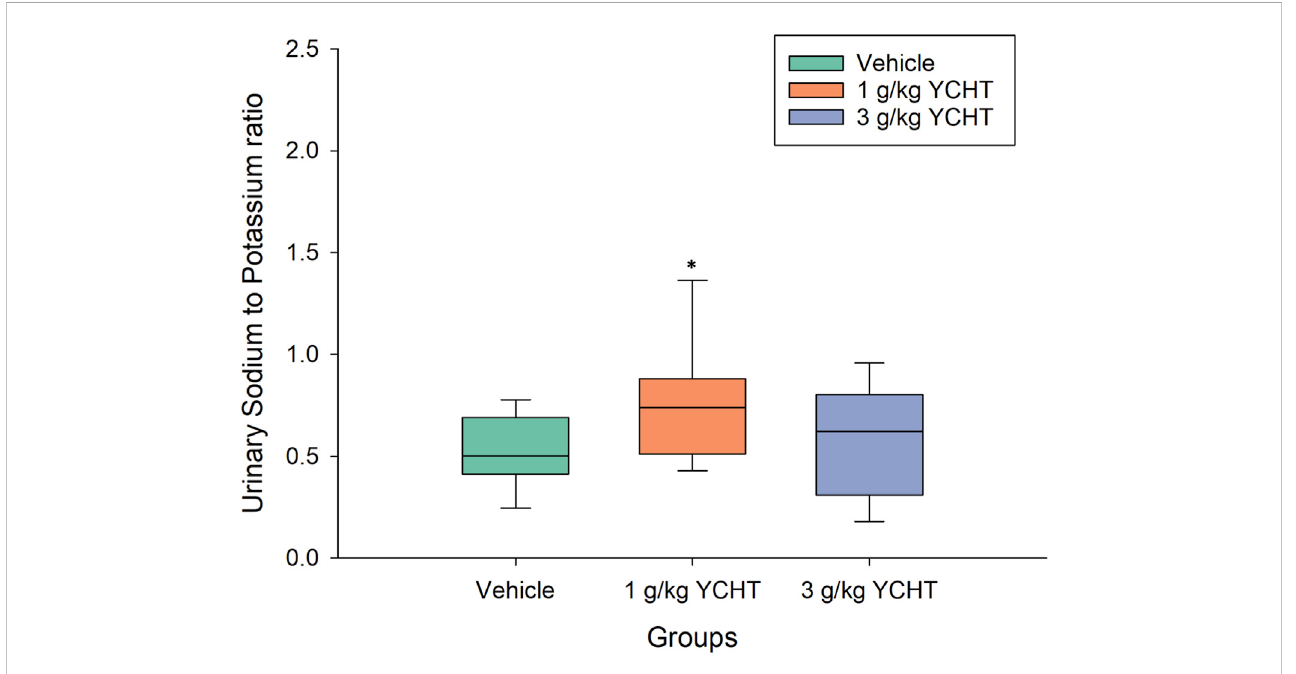
FIGURE 3 Urine sodium-to-potassium ratio of the vehicle and YCHT treated rats over 32 h. Data were signi fi cantly different by t-test. * p < .05; signi fi cance compared to the vehicle group; YCHT,